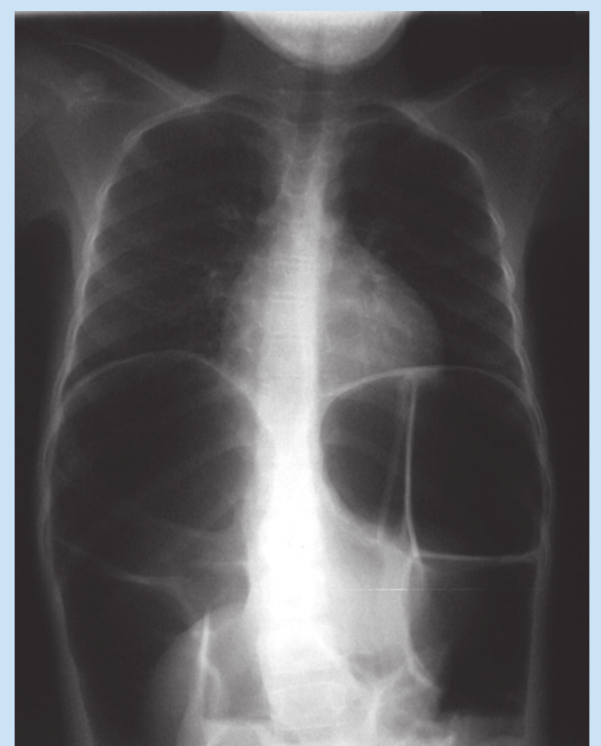
Fig. 1. Chest X-ray of 9-year-old Sotho